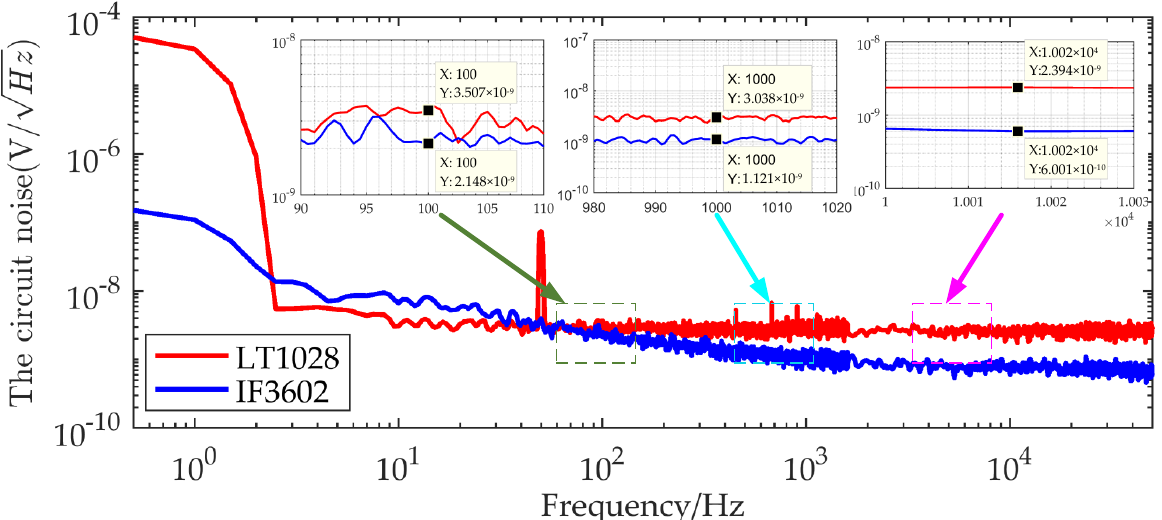
Figure 11. Comparison of the noise floor between the IF3602 circuit and the LT1028.